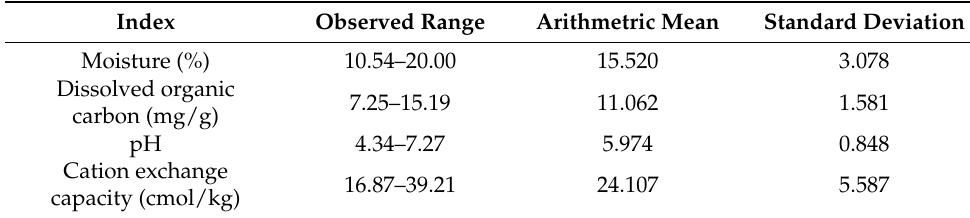
Table 2. Descriptive statistics of soil